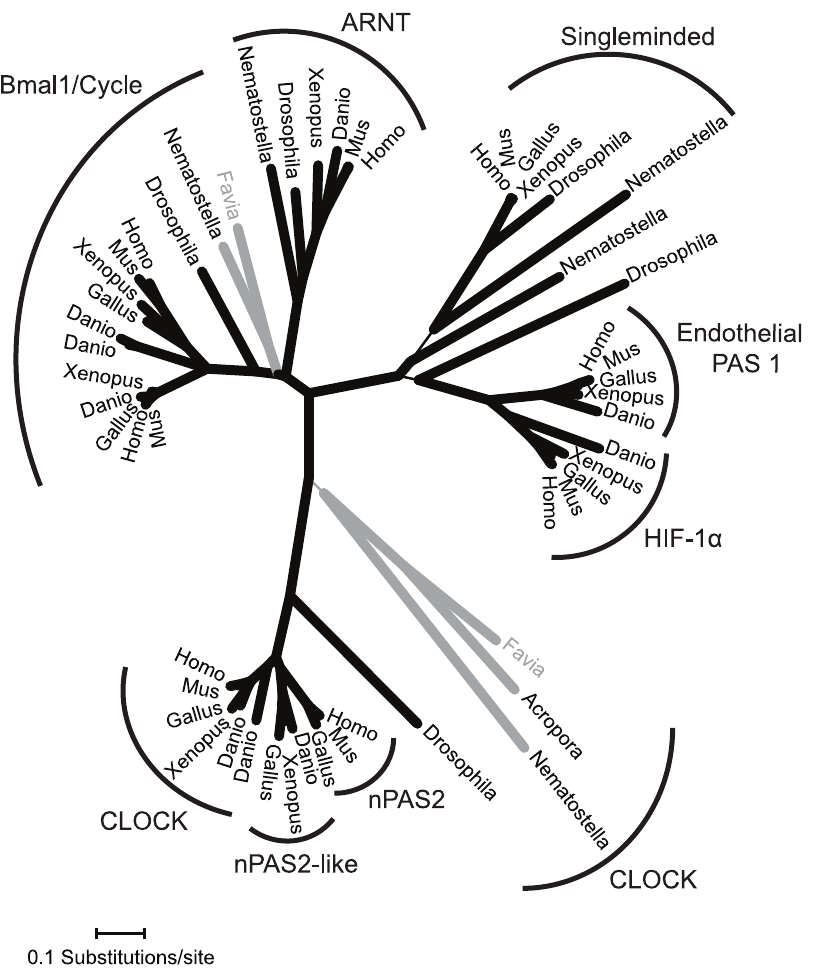
Figure 1. Phylogenetic relationship of the F.fragum genes clockandcycle. Tree depicts a radial consensus of 1000 bootstrap replicates using the Neighbor-Joining method with pairwise deletions and Poisson control. Analyses with 1000 bootstrap replicates under Dayhoff or JTT models were also run and resulted in similar phylogenetic relationships (data not shown). Thin lines represent nodes where less than 70% of the 1000 bootstrap replicates show support for the topology depicted above. Gray lines represent cnidarian lineages.